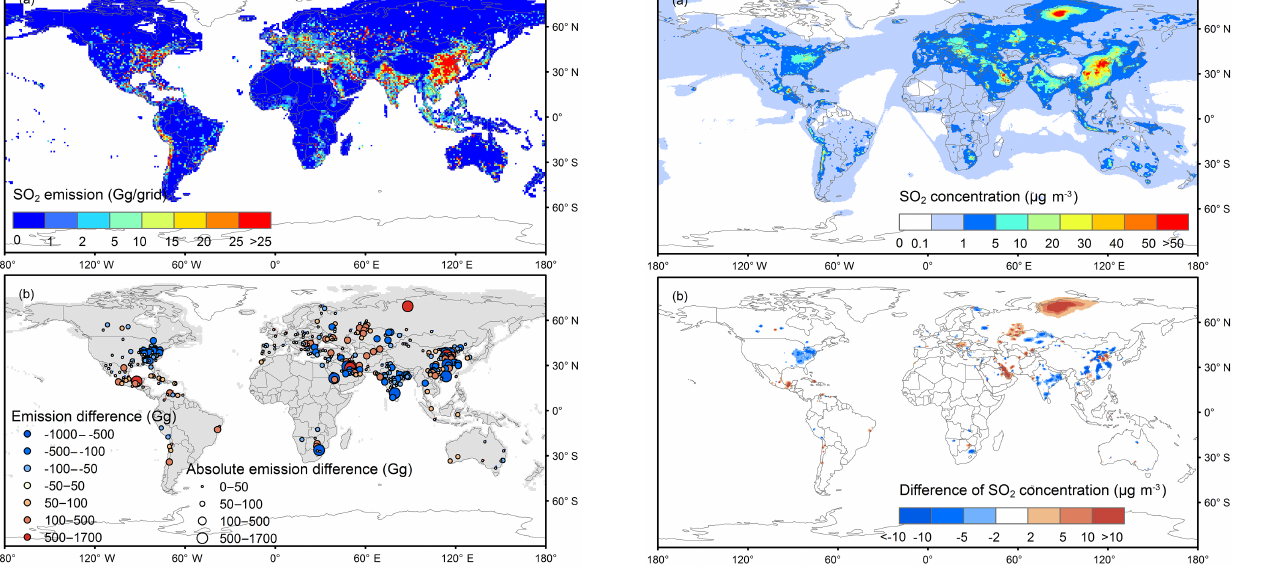
Figure 2. (a) Map for SO 2 emissions in the OMI-HTAP inventory, 2010. Emissions are regridded at the resolution of 1 ◦ × 1 ◦ for illus- tration. The unit is Gg-SO 2 per grid cell. The grid cells without SO 2 emissions are color coded with white. (b) The differences in emis- sions for individual OMI-detected sources between the OMI-HTAP and the HTAP inventory, 2010. Emissions for individual sources are calculated by summing up SO 2 emissions of each grid cells in the fitting domain (see Sect. 2.1). SO 2 emissions derived from the HTAP inventory are subtracted from those derived from the OMI- HTAP inventory to calculate the differences. The grid cells without emissions changes are color coded with grey. The unit is Gg-SO 2 per year.